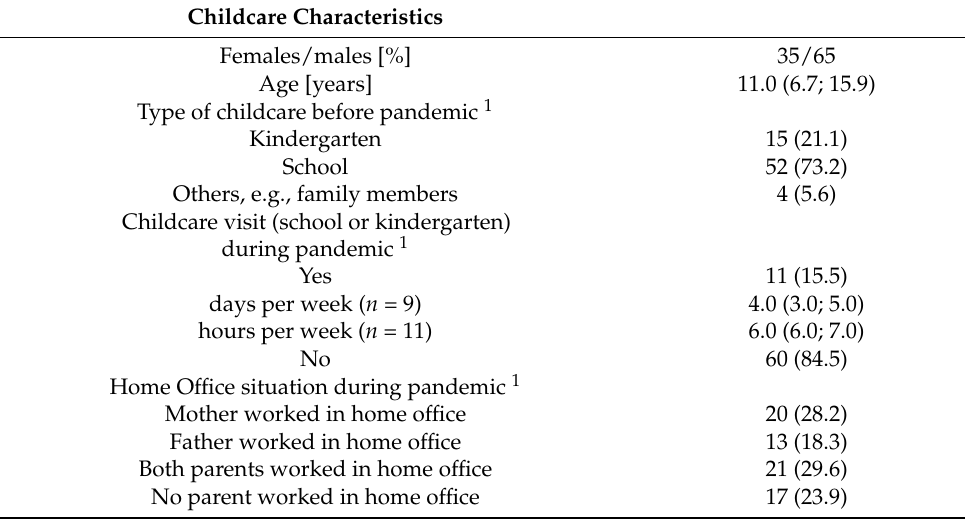
Table 3. Childcare characteristics of the DONALD participants (subgroup n =